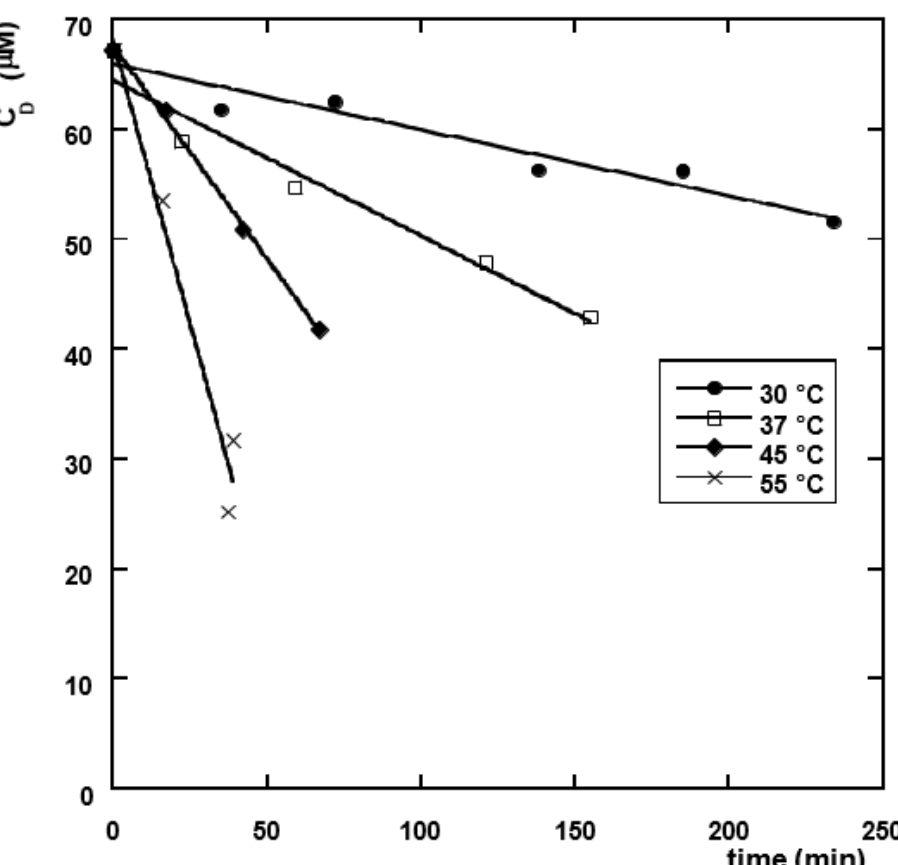
Figure 9. Diuron degradation kinetics profiles in the presence of PDS (4.5 g L − 1 ) at different temperatures modeled by using a zero-order kinetics equation (Equation (5)).